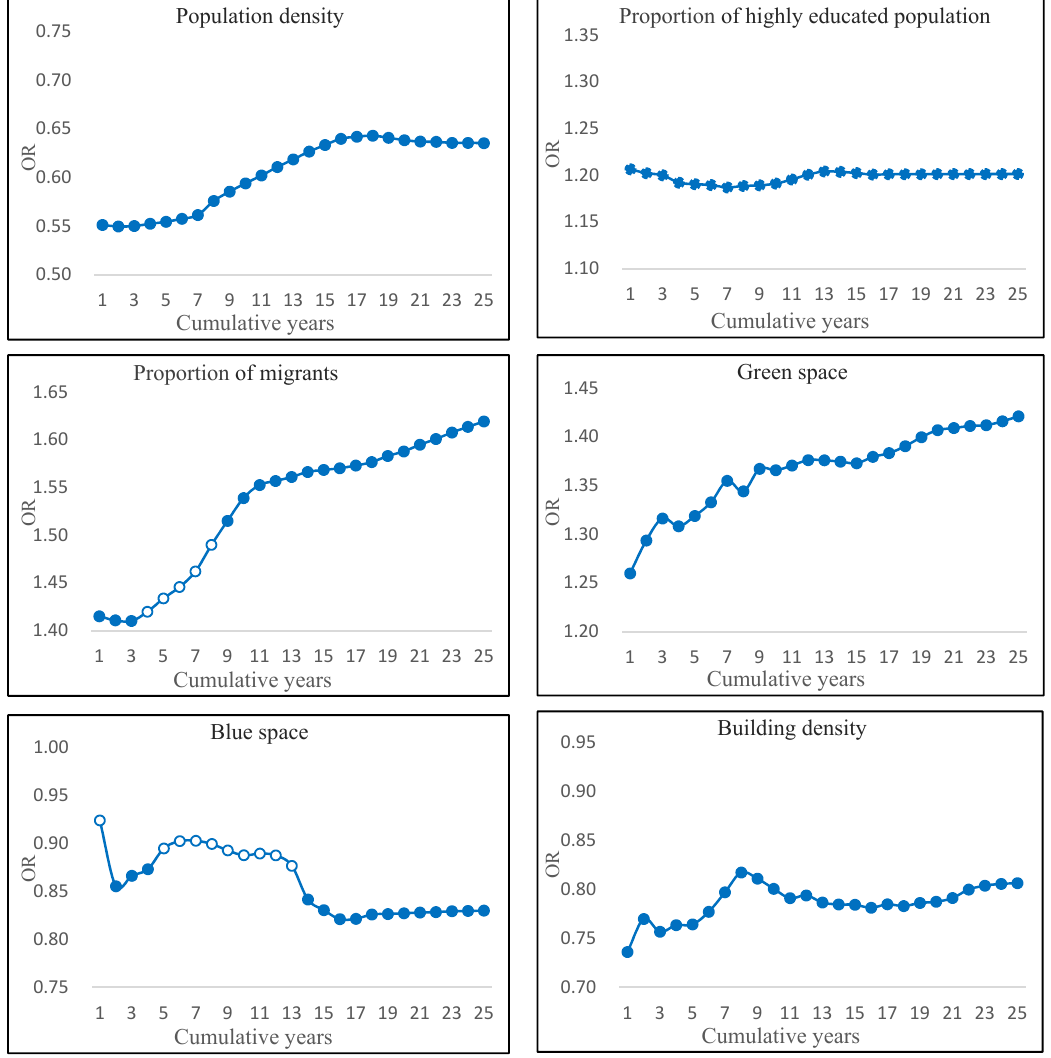
Figure 4. Accumulated exposure to residential environment and subjective wellbeing in later life. Note: Solid circles represent statistical significance at the 90% confidence interval, while hollow circles do not.